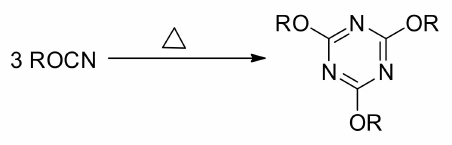
Figure 2. Scheme of cyclotrimerization of cyanate ester.